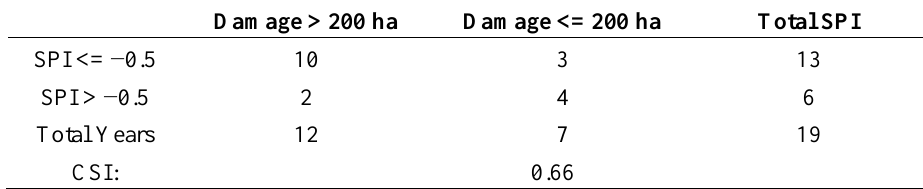
Table 4. Critical Success Index (CSI) for drought and paddy rice